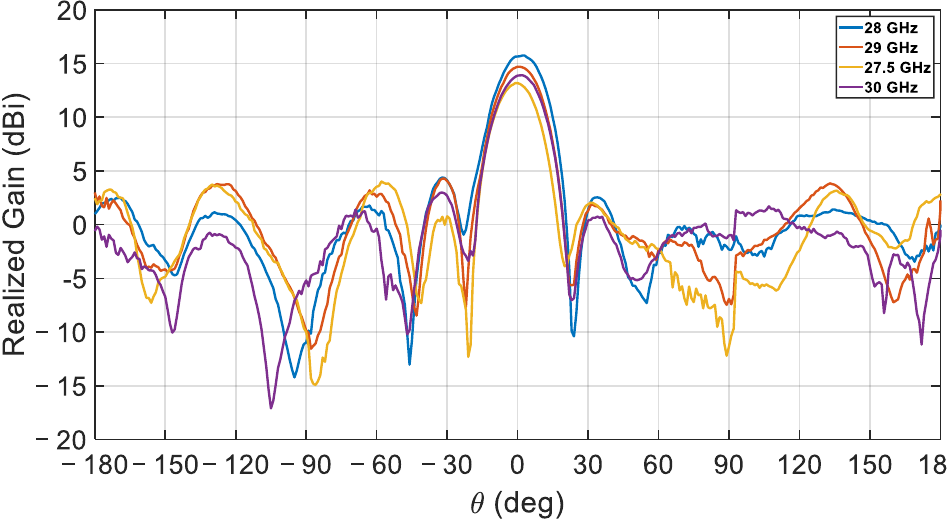
Figure 18. Measured realized gain for the proposed CDRA array.